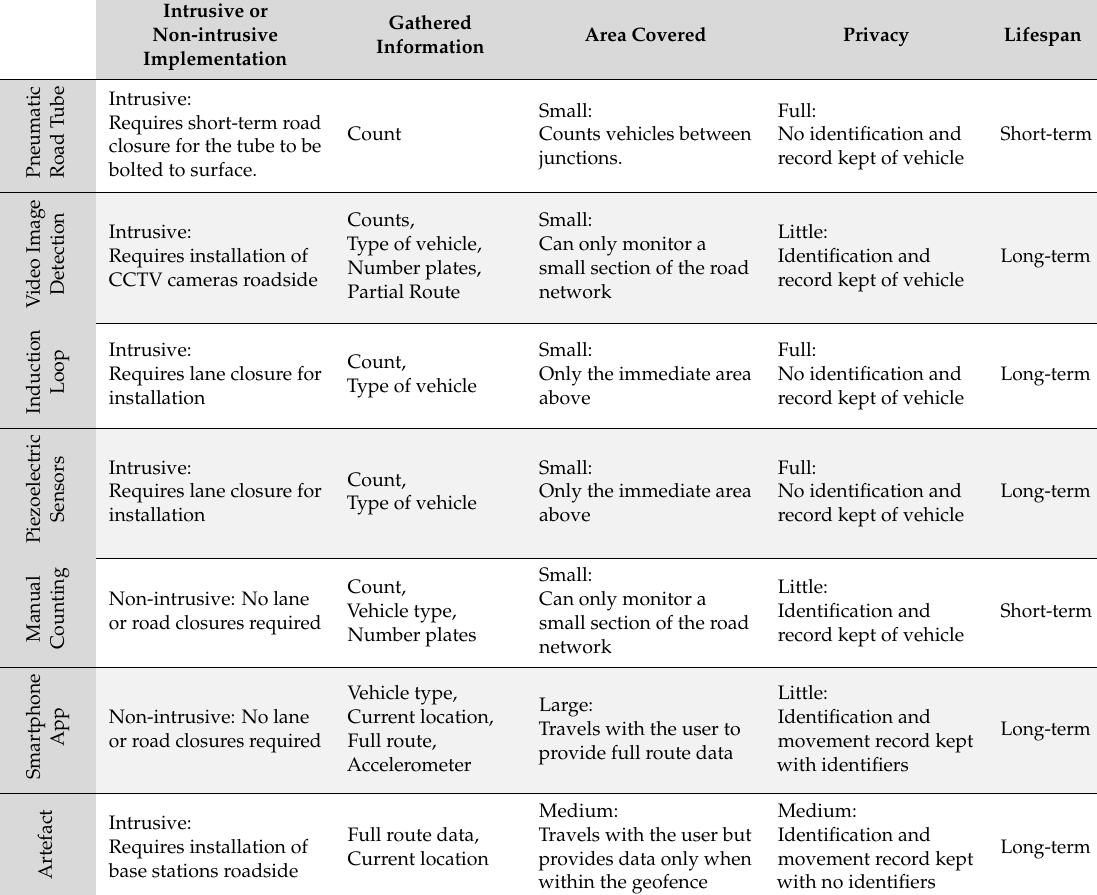
Table 1. Comparison between the different solutions and this project’s